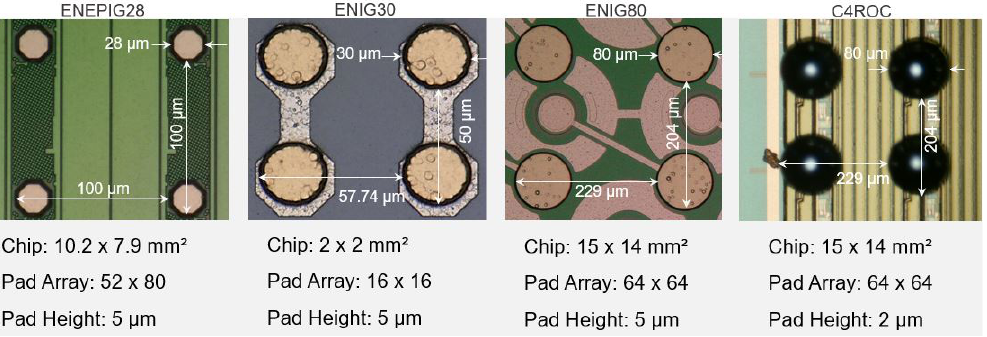
Figure 2. Micro photographs showing regions of four contacts of samples with Ni-based